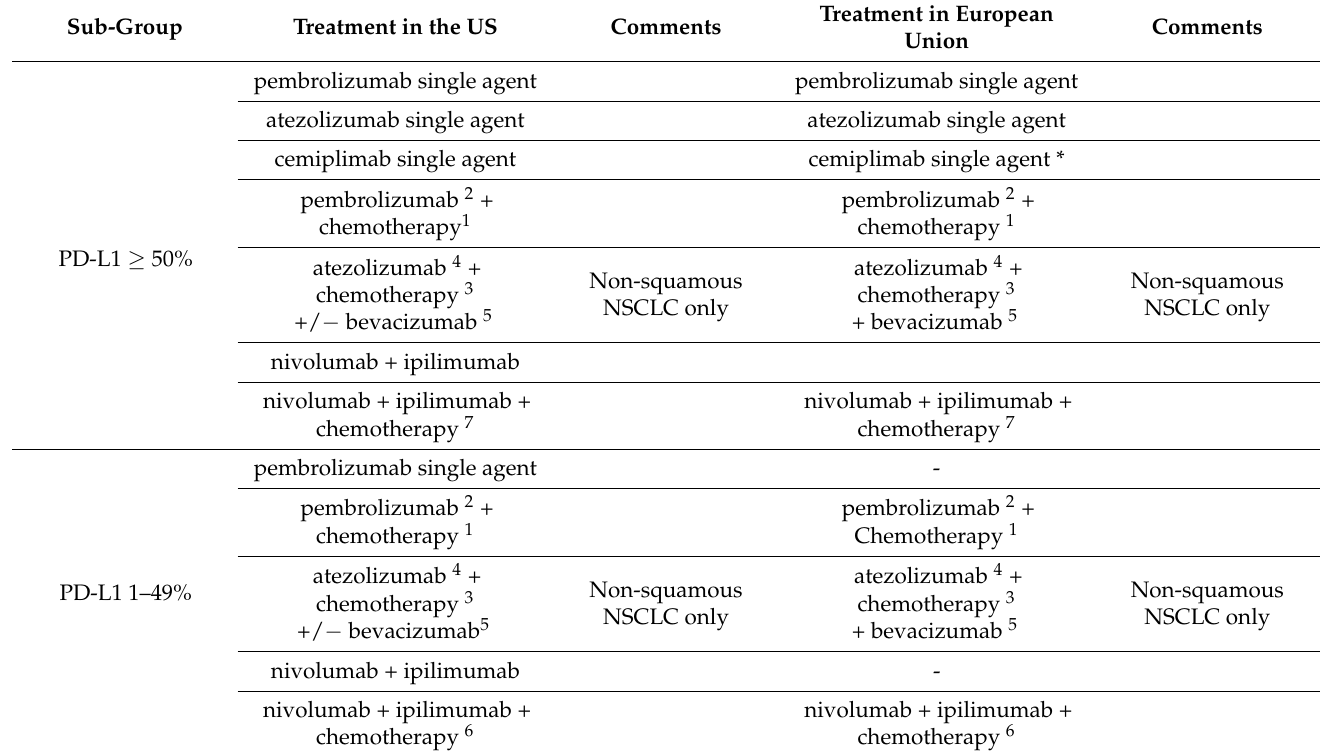
Table 2. Algorithm for front line immune checkpoint inhibitors’ treatment of patients with NSCLC based on PD-L1 expression.